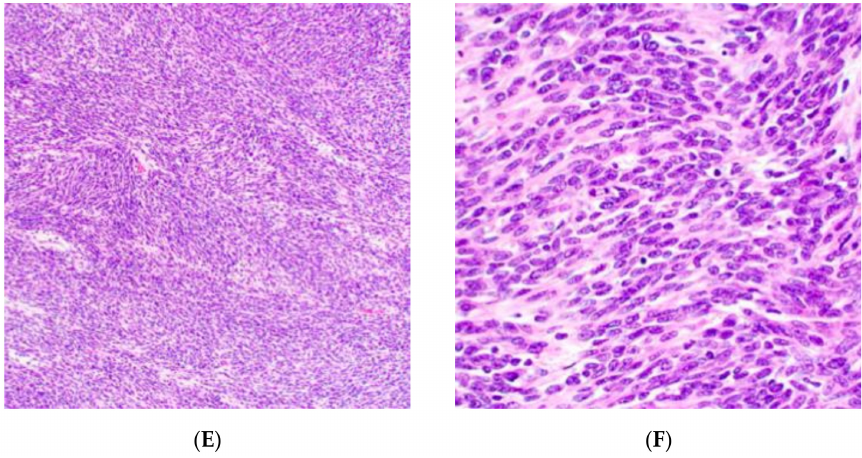
Figure 3. Spontaneous features of NF in pigs. Cutaneous pigmented neurofibroma ( A – C ) and MPNST ( D – F ). ( A ) Pigmented mass in the skin of the ventral abdomen. Bar, 3 cm [38]. ( B ) Cutaneous pigmented neurofibroma. The non-pigmented spindle cell population forms fascicles, bundles, and variably sized nodules. Bar, 100 µ m [38]. ( C ) Cutaneous pigmented neurofibroma Perineurial-like cells (arrowheads) and neoplastic Schwann cells (asterisks) express nerve growth factor receptor (NGFR P75). IHC. Bar, 50 µ m [38]. ( D ) MPNST. A firm mass expands the right humerus, elbow joint, and proximal radius and ulna [40]. ( E ) MPNST. The neoplasm is composed of closely packed, interweaving short streams and bundles of spindle cells in a fine fibrovascular stroma. H&E [40]. ( F ) MPNST. Closer view of the neoplasm with interweaving streams and bundles of pleomorphic spindle cells. H&E